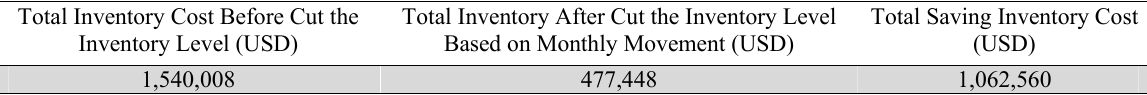
Saving Inventory Cost After Cut the Inventory to The Lowest Level Total Inventory Cost Before Cut